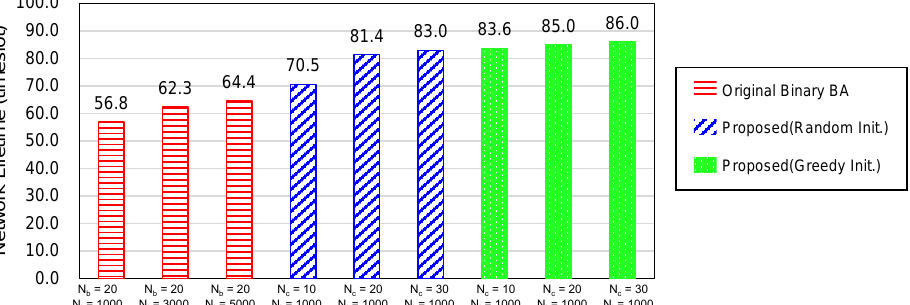
Figure 10. Average network lifetime according to the versions of Binary Bat Algorithm.